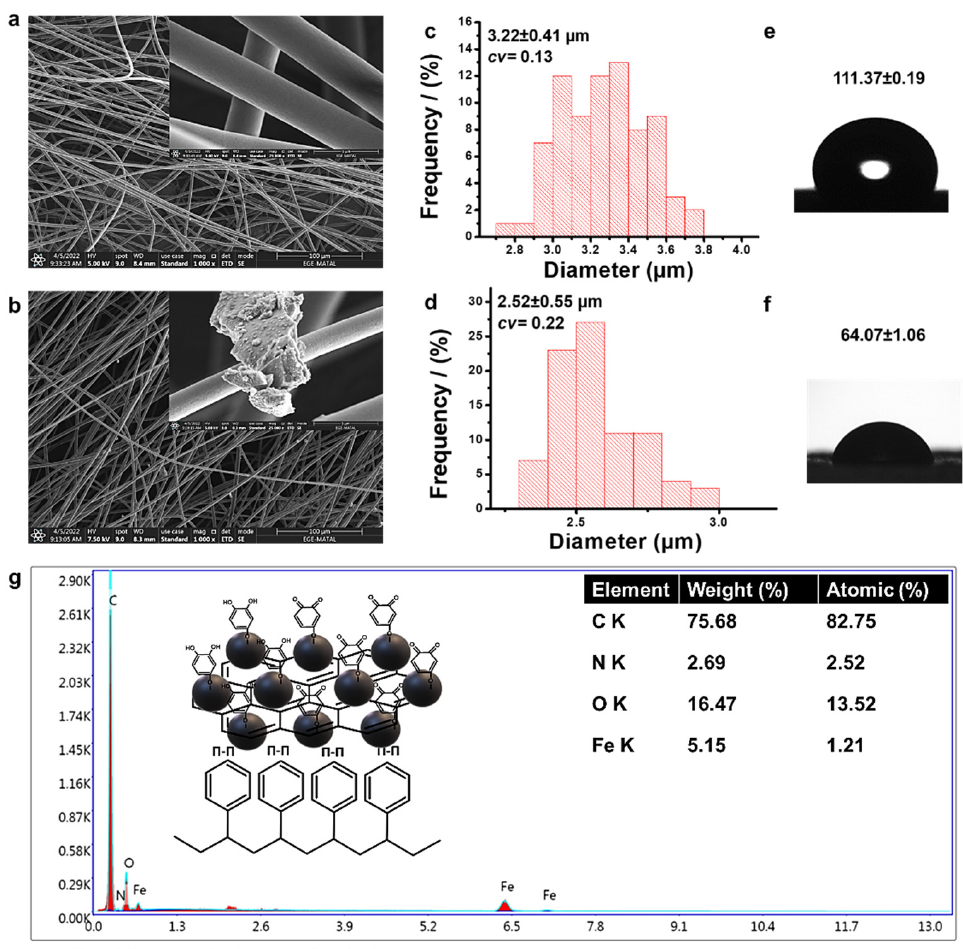
Figure 3. SEM images (1000 × magnification) of ( a ) PS (35%) (w/v), ( b ) PS/rGO-MNP-PDA 0.5% (w/v), (interior SEM images (25.000 × magnifications); diameter distribution graphics of nanofibers ( c ) PS (35%) (w/v), ( d ) PS/rGO-MNP-PDA 0.5% (w/v) electrospun nanofibers, contact angle meas- urements of ( e ) PS (35%) (w/v), ( f ) PS/rGO-MNP-PDA 0.5% (w/v) electrospun nanofibers, and ( g )